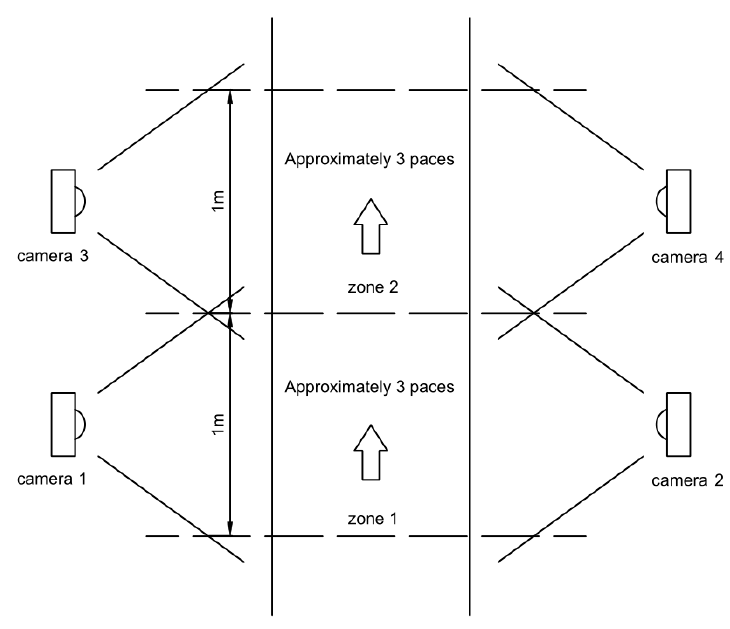
Figure 2. Layout diagram of workplace for exoskeleton.